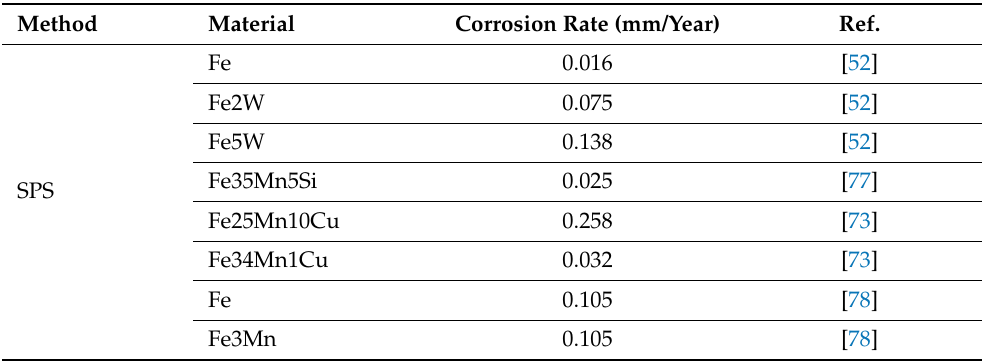
Table 3. Corrosion rates for Fe-based materials obtained by spark plasma sintering.